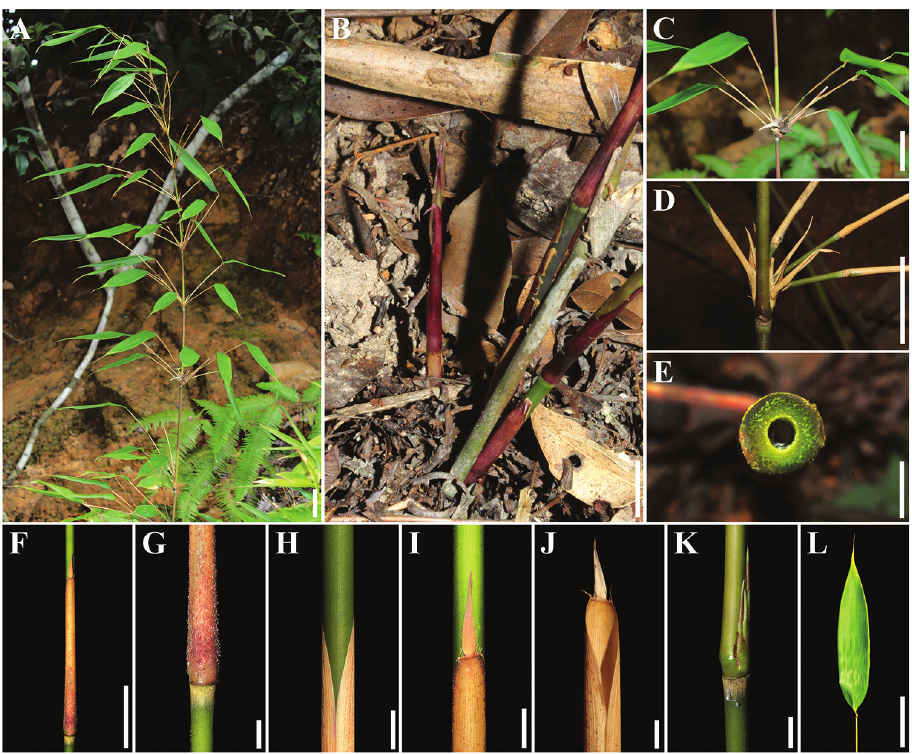
Figure 4. Gelidocalamus xunwuensis . A habitat plants B new shoot C–L detailed characters, show branch and branch sheath ( C–D ), transection of culm and pith-cavity ( E ), culm and its leaf sheath ( F–J ), buds ( K ) and foliage leaf ( L ). Scale bar: 5 cm (A–D, F, L ), 5 mm ( E, G–K